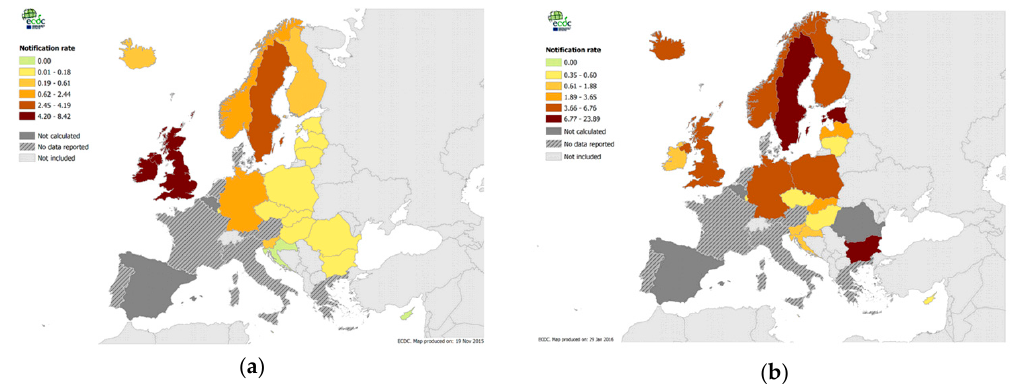
Figure 4. ECDC 2014 data on the distribution in Europe of reported confirmed cases per 100,000 population of ( a ) cryptosporidiosis [25]; ( b ) giardiasis [26].